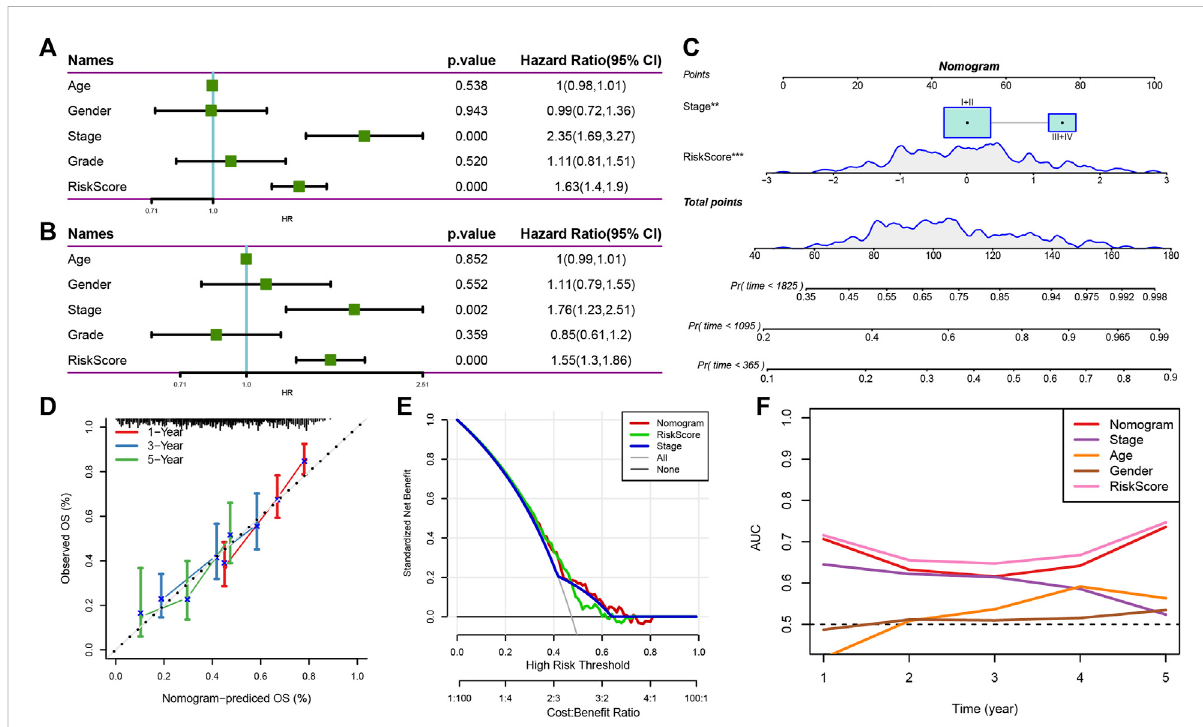
FIGURE 10 Nomogram of RS combined with clinical pathological characteristics. (A,B) Univariate and Multivariate Cox regression analysis of the RS and clinicopathological features; (C) Nomograph model; (D) Calibration curve of nomograph in 1, 3, and 5 years; (E) Decision curve of nomograph; (F) When compared to a few other clinicopathological characteristics, the nomogram displayed a good capacity for OS